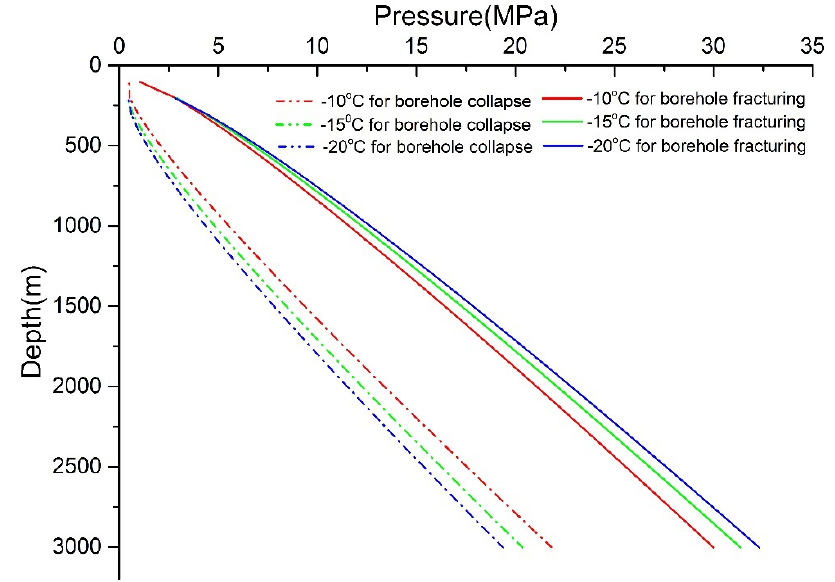
Figure 6. Critical borehole fracturing and collapse pressure changes at different temperatures calculated by the teardrop criterion.